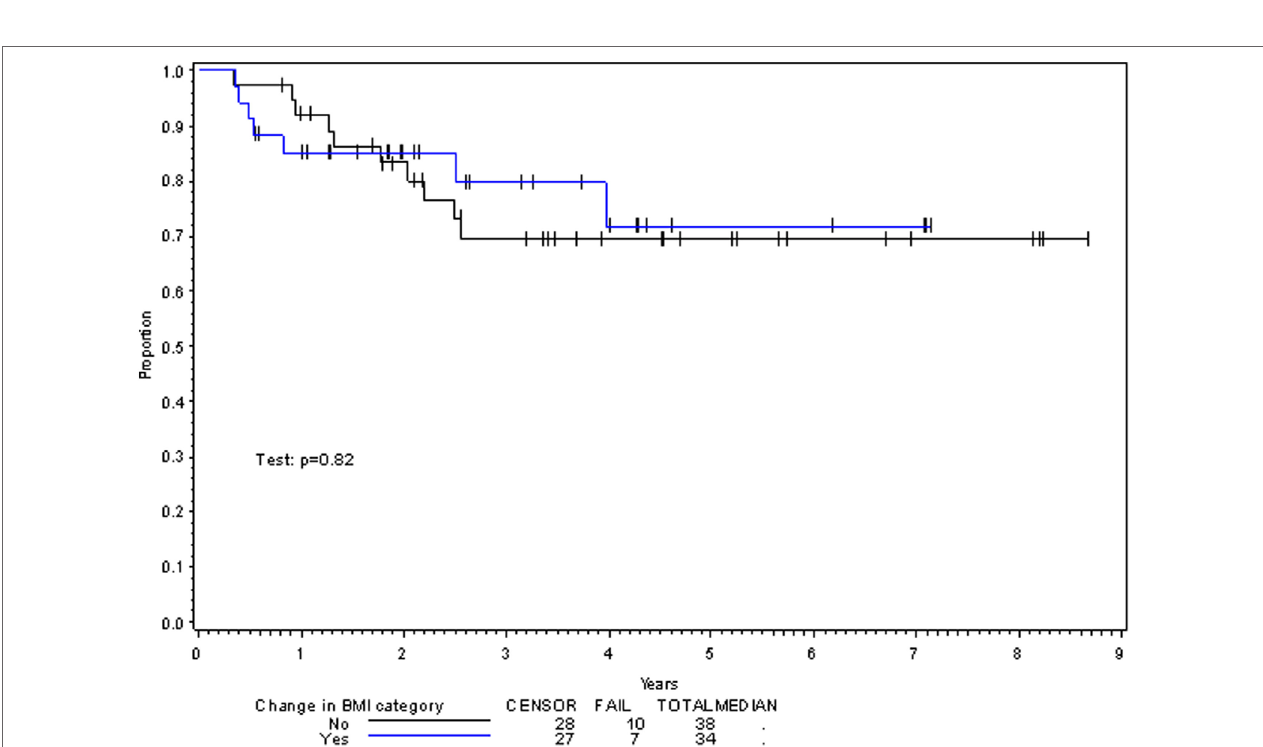
FigUre 4 | Overall survival per change in BMI category with